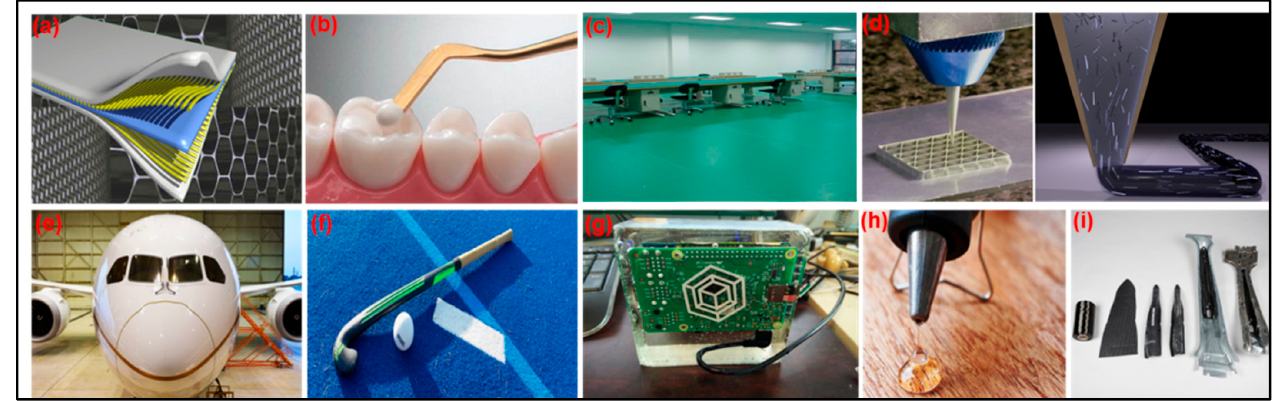
Figure 1. Potential applications of thermosets: ( a ) composite materials, ( b ) dental filling, ( c ) floor coatings, ( d ) 3-D printing, ( e ) plane body structure, ( f ) sports items, ( g ) electronics products, ( h ) adhesive, and ( i ) automobile parts.